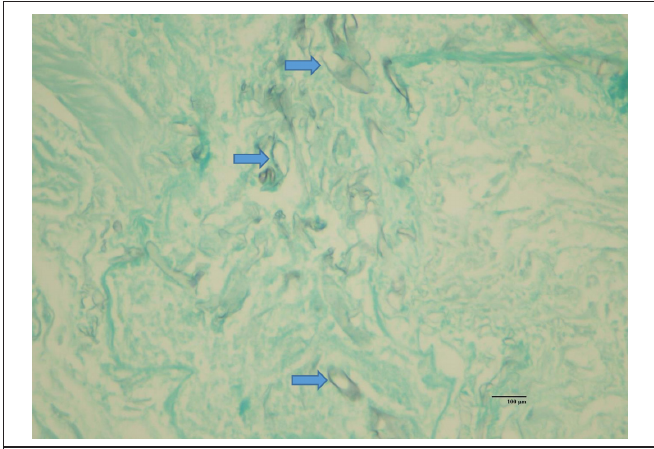
Figure 4. Fungal structures belonging to mucormycosis staining positive for histochemical Gomori methenamine silver. (GMS X 400 [gomorinin gümüş